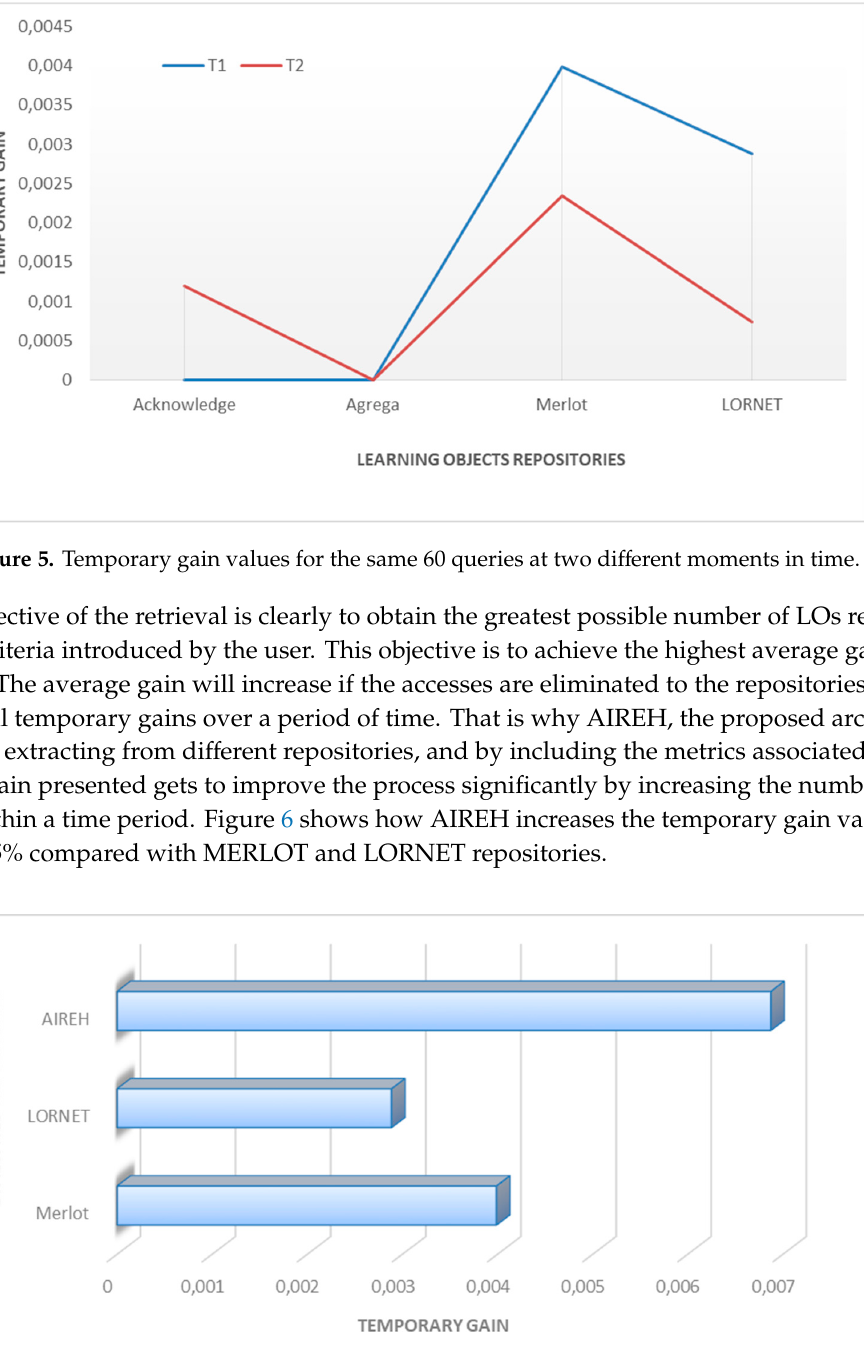
Figure 6. Comparison of temporary gain in AIREH, Learning Object Repository Network (LORNET), and Multimedia Educational Resource for Learning and Online Teaching (MERLOT), during the test phase of the proposed architecture.